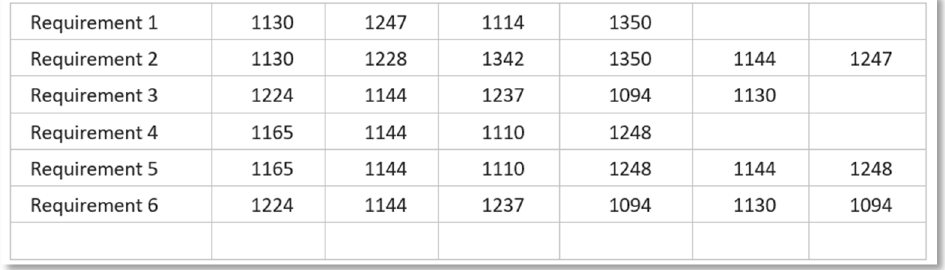
Figure 10. Sample Population of Requirements.